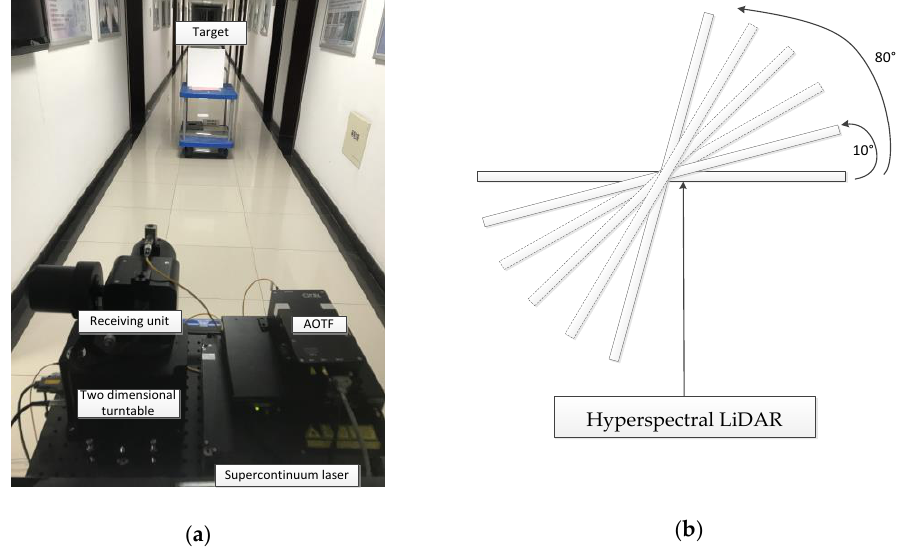
Figure 4. Measuring platform: ( a ) The HSL experimental platform; ( b ) Sample angle measuring platform.